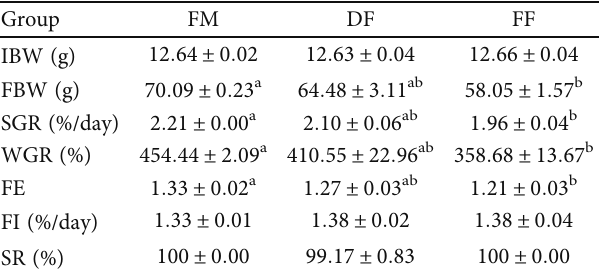
Table 5: The growth performance of